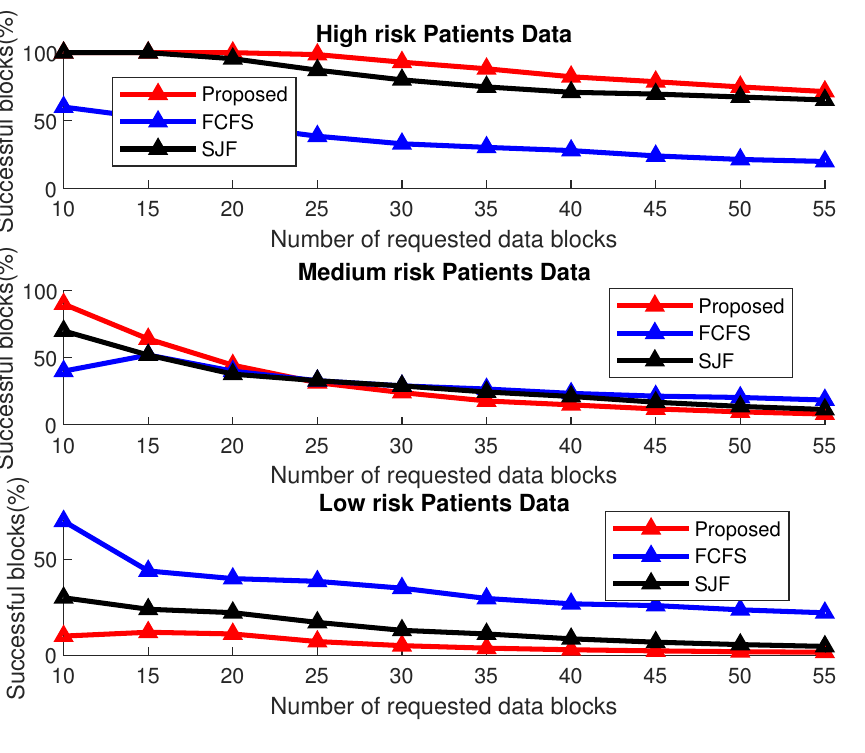
Figure 16. Successful transmission of priority data for a varying number of requested data